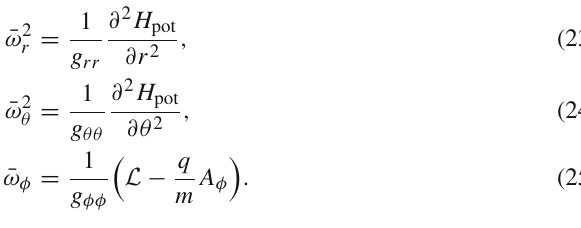
defined by the second derivative of V eff as